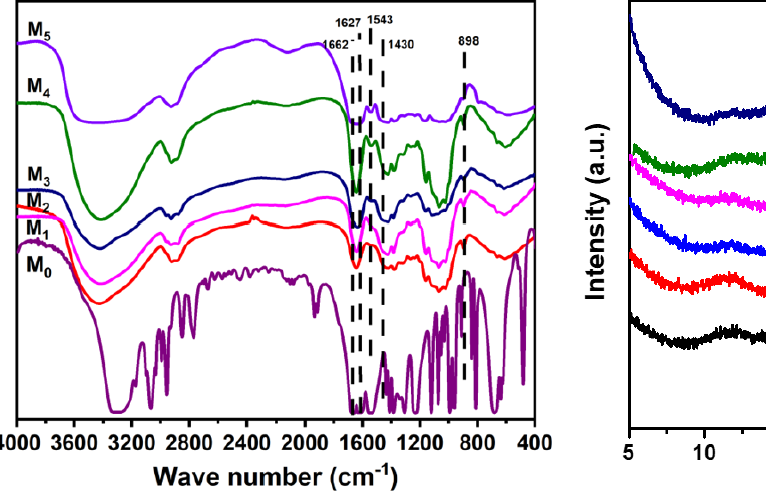
Figure 7: FTIR spectra of the cross-linking agent treated cellulose hydrogel scaffolds. M 0 : the MBA, M 1 -M 5 : the cellulose hydrogel scaffolds treated with 0.2, 0.4, 0.6, 0.8, and 1.0 wt% MBA solutions, respectively